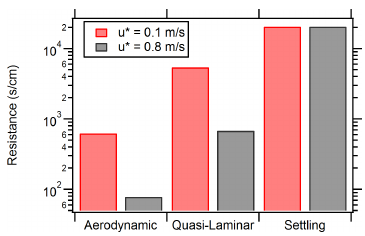
Figure 9. Deposition and particle settling (accounts for the effect of sedimentation) resistance comparison for low and high friction velocities. Resistance comparison assumes a 1µm particle